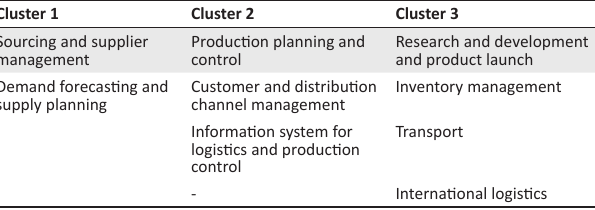
TABLE 8: Competence-performance improvement skills